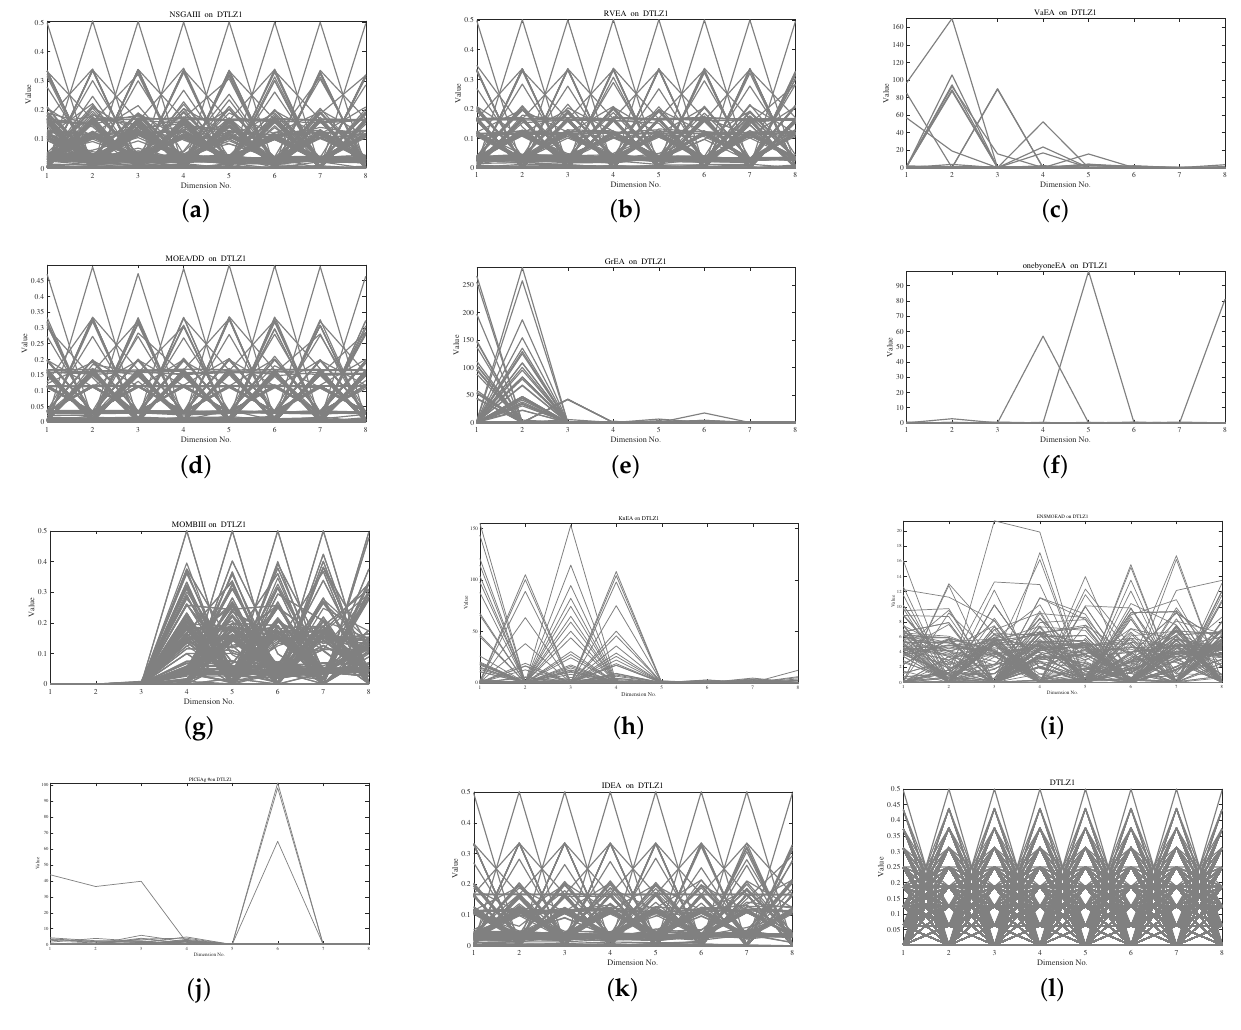
Figure 5. DTLZ1 8-dimensional parallel coordinates system. ( a ) NSGA-III. ( b ) RVEA. ( c ) VaEA. ( d ) MOEA/DD. ( e ) GrEA. ( f ) onebyoneEA. ( g ) MOMBI-II. ( h ) KnEA. ( i ) ENSMOEAD. ( j ) PICEAg. ( k ) IDEA. ( l ) True PF.